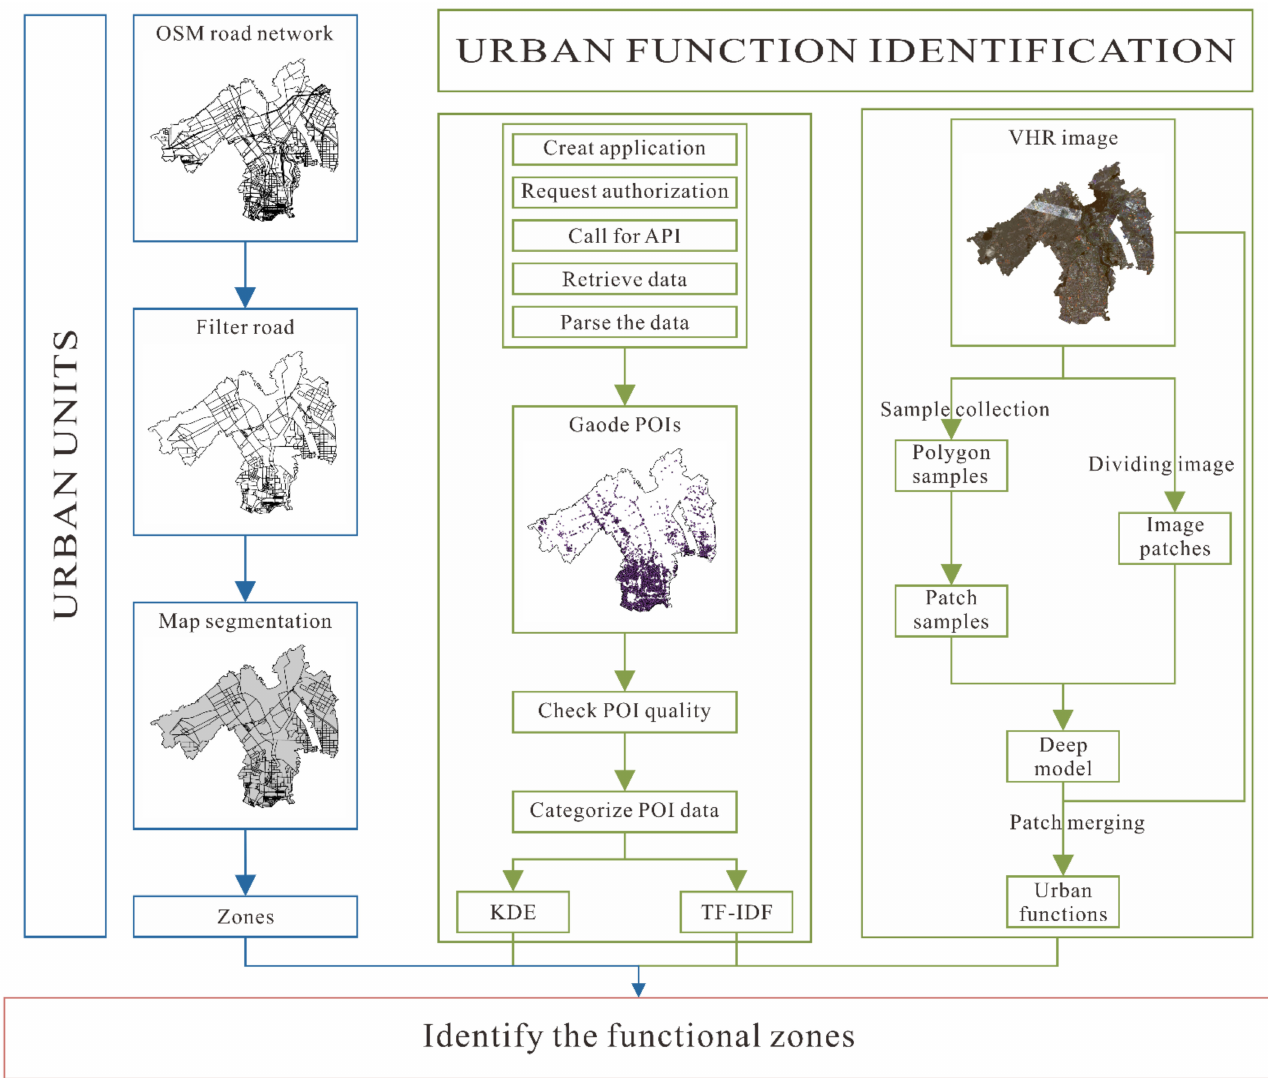
Figure 2. Flowchart of the